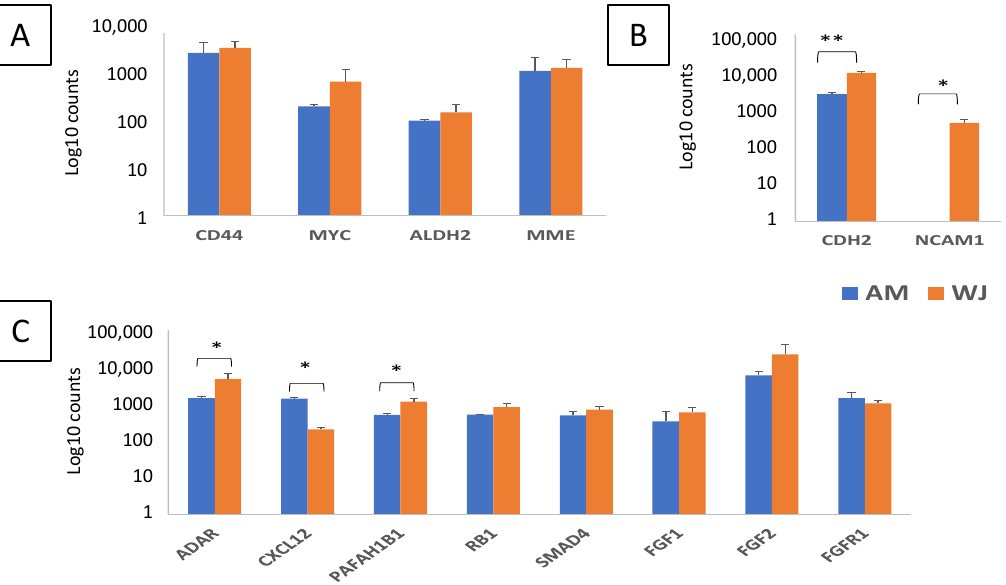
Figure 1. Differential expression of genes associated with self-renewal and stemness in AM- and WJ-MSCs under basal condition. ( A ) Stemness, ( B ) cell adhesion and ( C ) self-renewal genes. Data represented mean counts ± SD. Asterisks (*) and (**) represent statistical significance of p < 0.05 and p < 0.005, respectively.